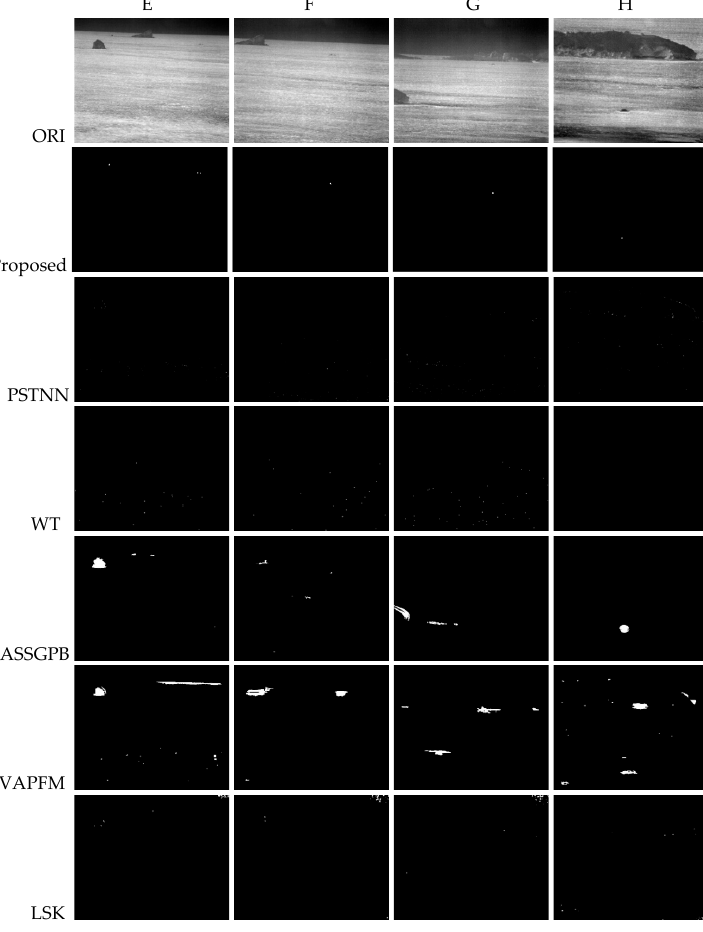
Figure 13. Detection results of different algorithms.